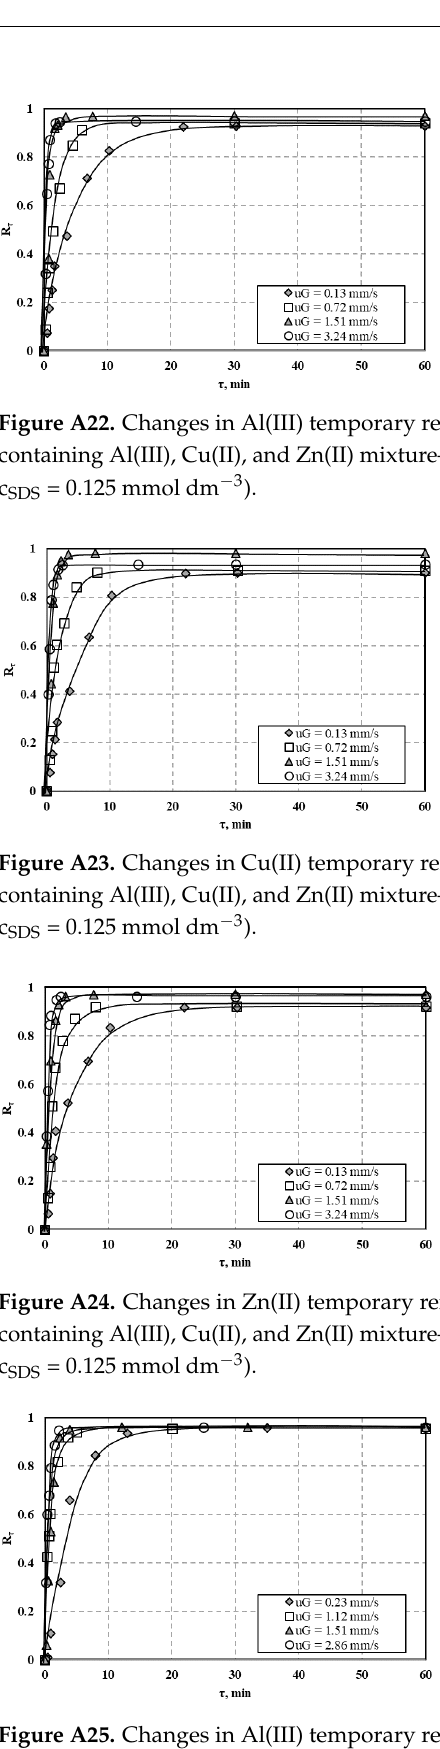
Figure A26. Changes in Cu(II) temporary removal ratio during precipitate flotation from solution containing Al(III), Cu(II), and Zn(II) mixture—effect of air velocity (c 0 = 2 mmol dm − 3 , pH = 8.7, c SDS = 0.187 mmol dm − 3 ). Figure A27. Changes in Zn(II) temporary removal ratio during precipitate flotation from solution containing Al(III), Cu(II), and Zn(II) mixture—effect of air velocity (c 0 = 2 mmol dm − 3 , pH = 8.7, c SDS = 0.187 mmol dm − 3 ). References 1.